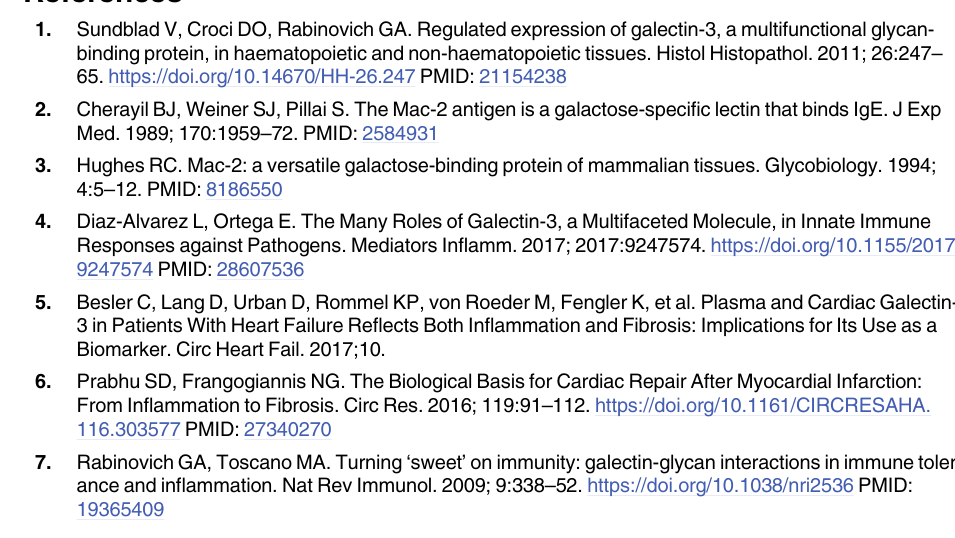
S1 Fig. The evaluation of inflammatory response was graded as 0 = noe, 1 = mil, 2 = moder- ate, and 3 = severe as shown in the picture. Scale bar = 50 μ